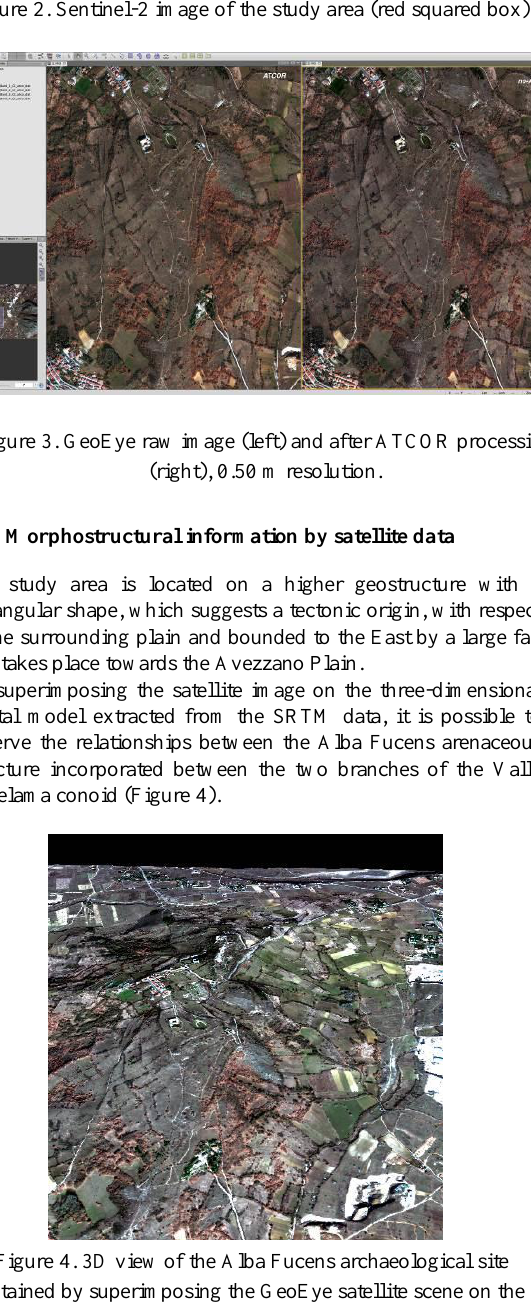
Figure 2. Sentinel-2 image of the study area (red squared box).